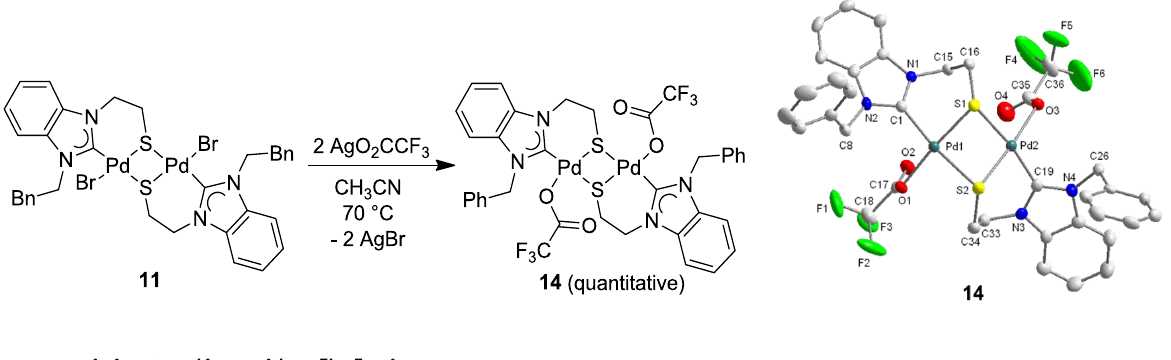
Figure 15. Synthesis of Pd(II) trifluoroacetato complex 14 and its molecular structure